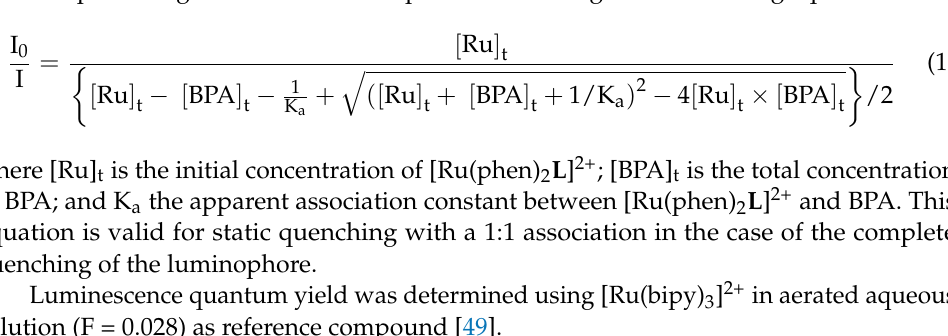
L , Figure S4: 13 C-NMR spectra of compound L , Figure S5: 1 H-NMR spectra of [Ru(phen) 2 L ] 2+ , Figure S6: 13 C-NMR spectra of [Ru(phen) 2 L ] 2+ , Figure S7: HR-ESI MS spectra of [Ru(phen) 2 L ] 2+